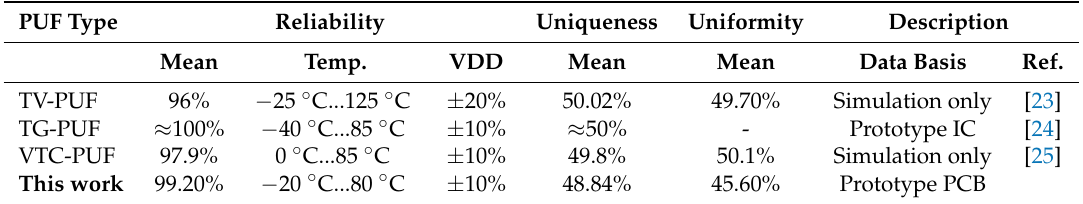
Table 2. Security metrics comparison with related